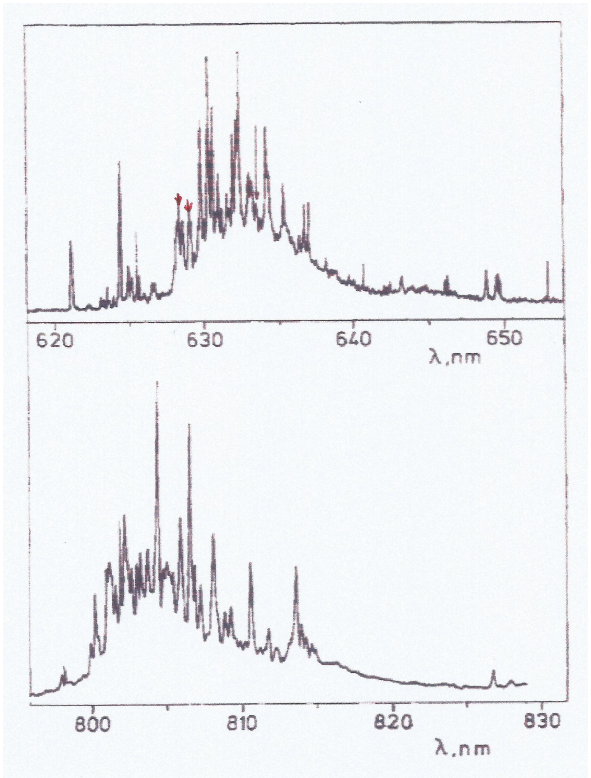
Figure 6. Fluorescence (upper trace) and phosphorescence (lower trace) of Cd-tetrabenzoporphyrines in n-octane at 4.2K. (Platenkamp and Canters 1981).